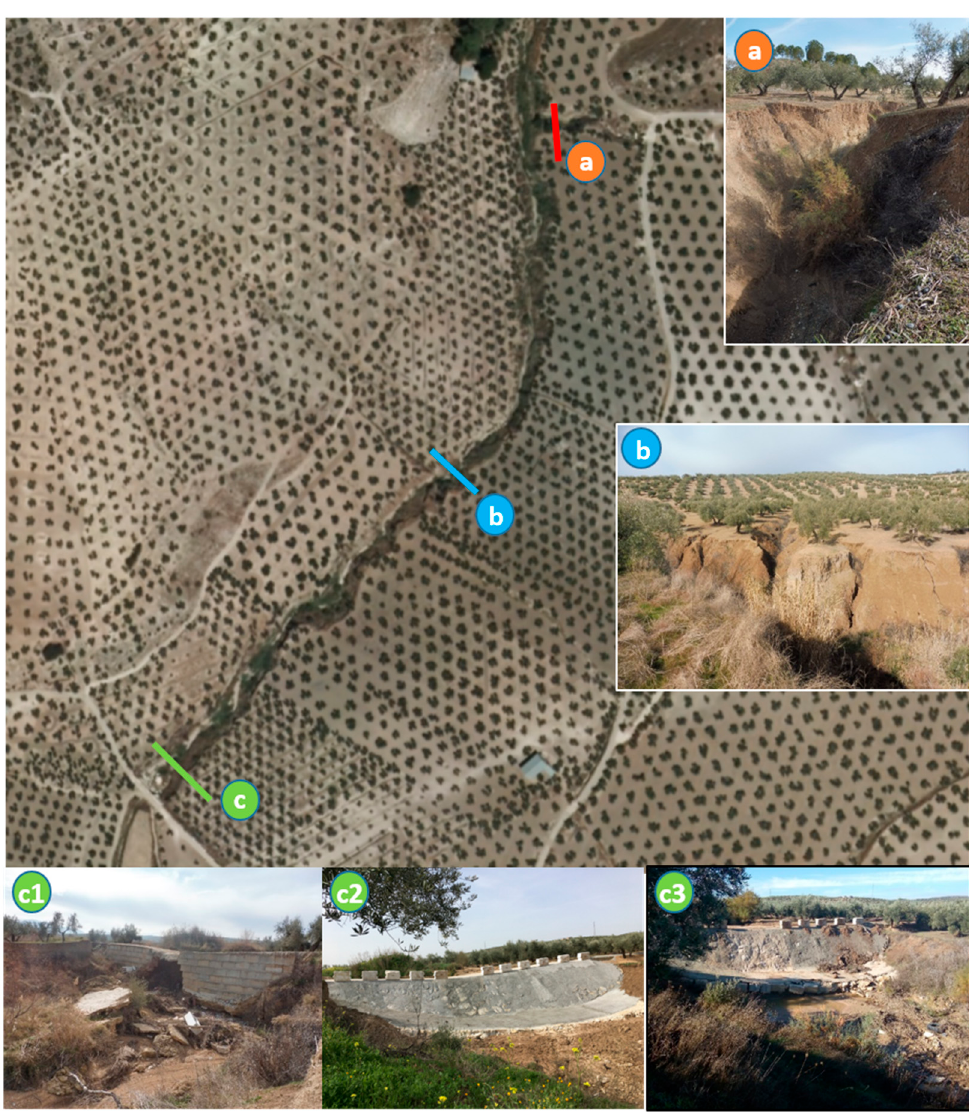
Figure 2. Photographs of different sectors of the gully area: ( a ), ( b ) and ( c ) sections; ( c1 ), ( c2 ) and ( c3 ): rural way affected by erosion processes in January 2016, January 2017 and January 2018, respectively.